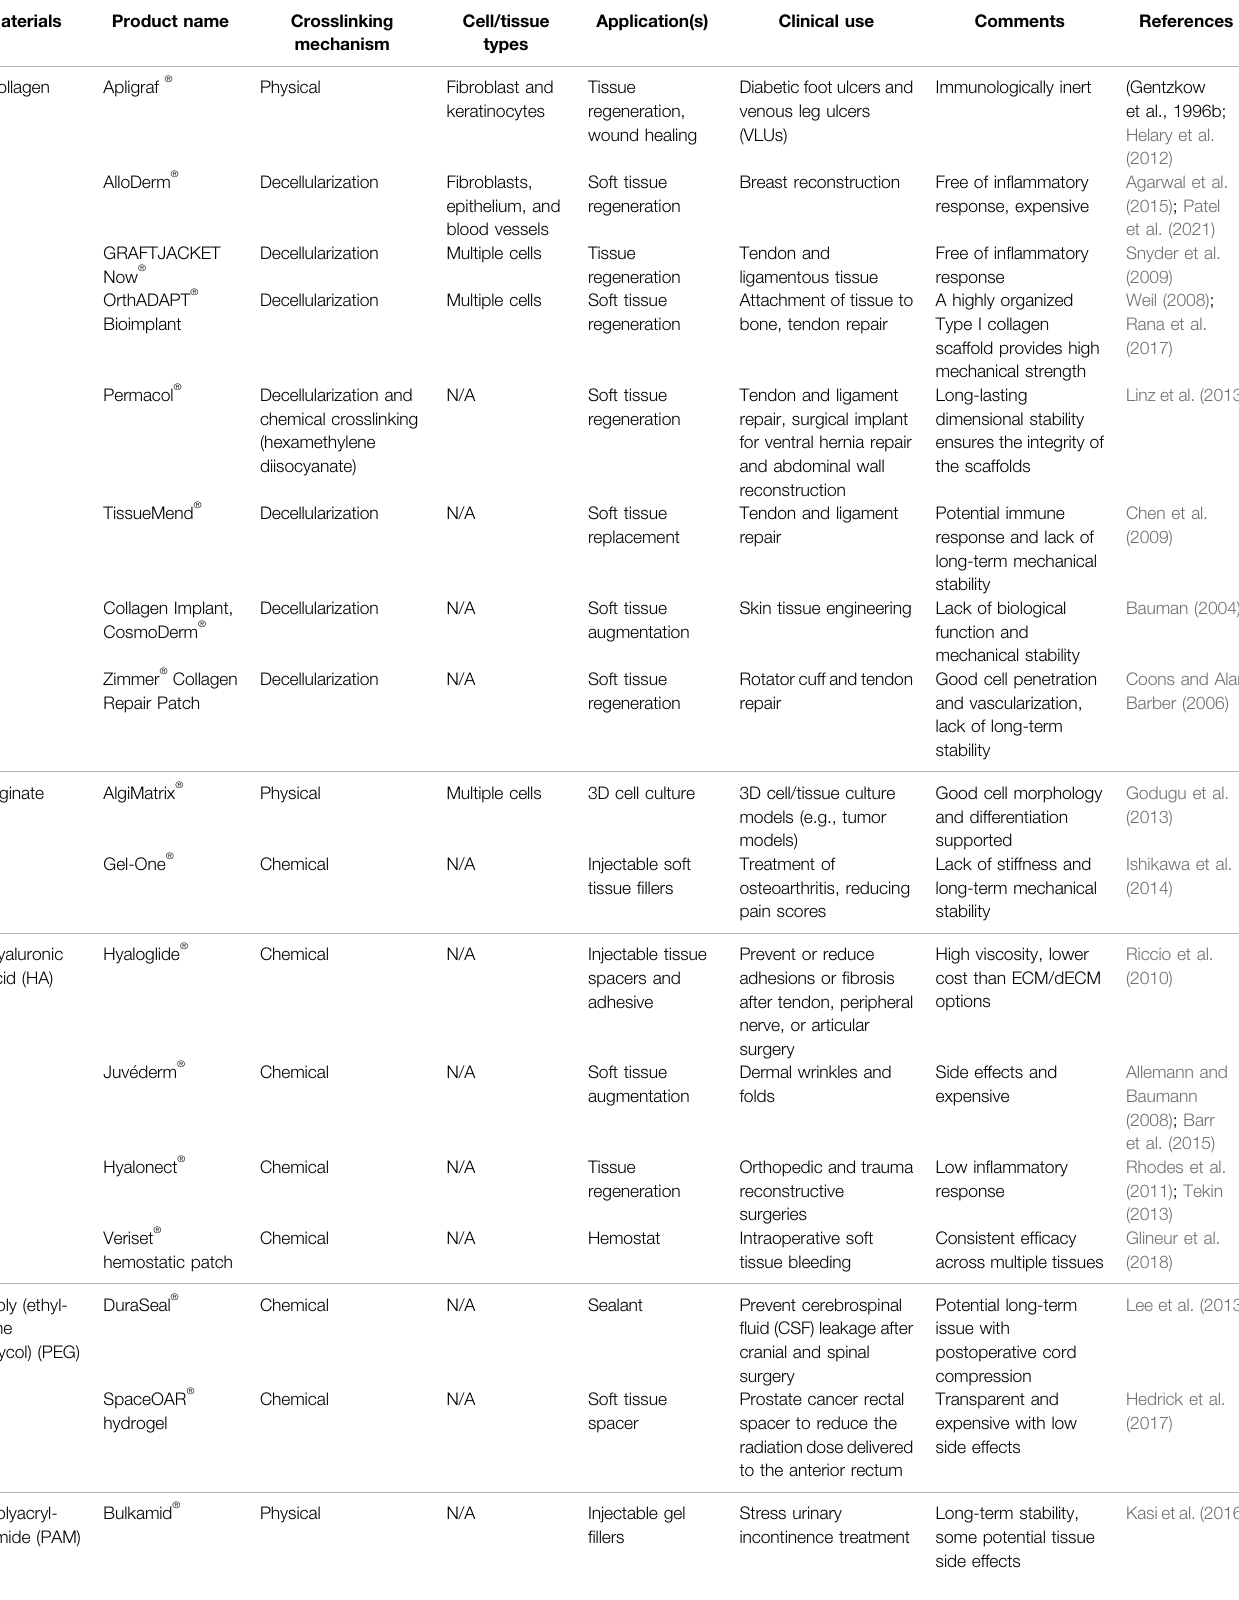
TABLE 3 | Commercialized hydrogels used in the clinic.